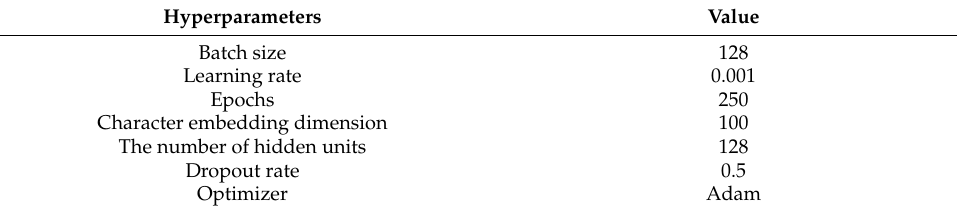
Table 3. The model parameters.